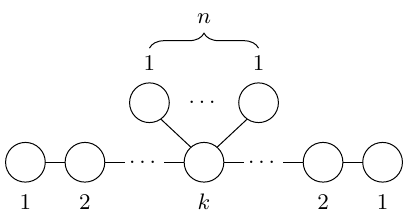
Figure 3 . A series quiver with P